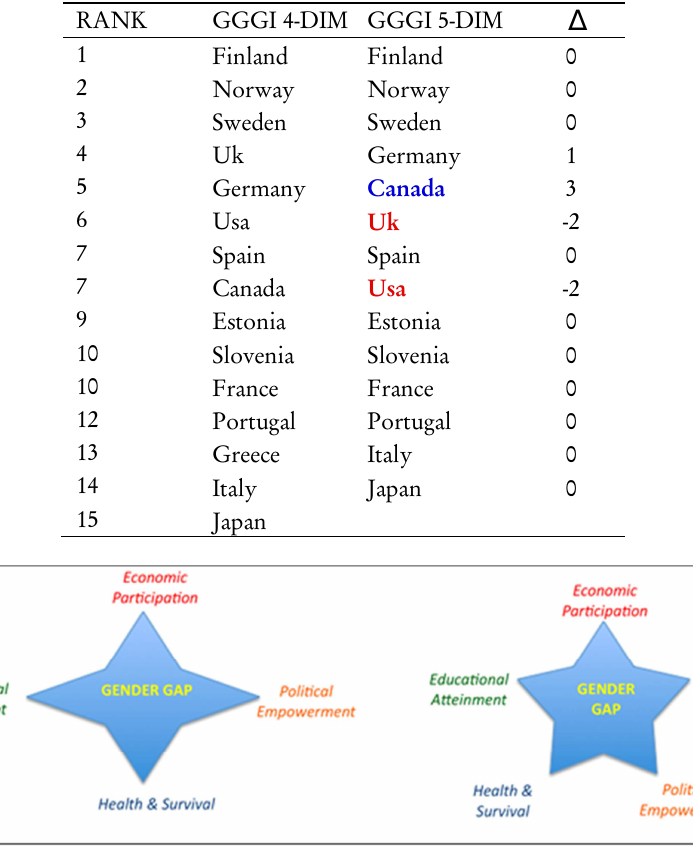
Comparison between GGGI 4 dimensions and GGGI 5 dimensions adding TUS component